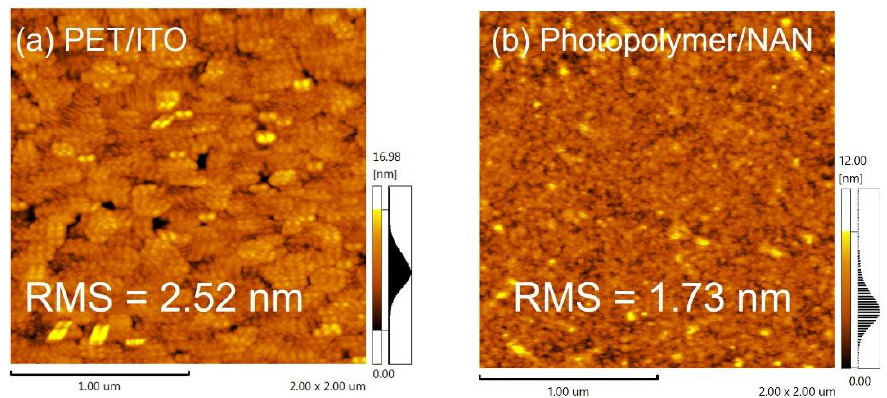
Figure 3. AFM images of ( a ) PET/ITO and ( b ) Photopolymer/NAN.